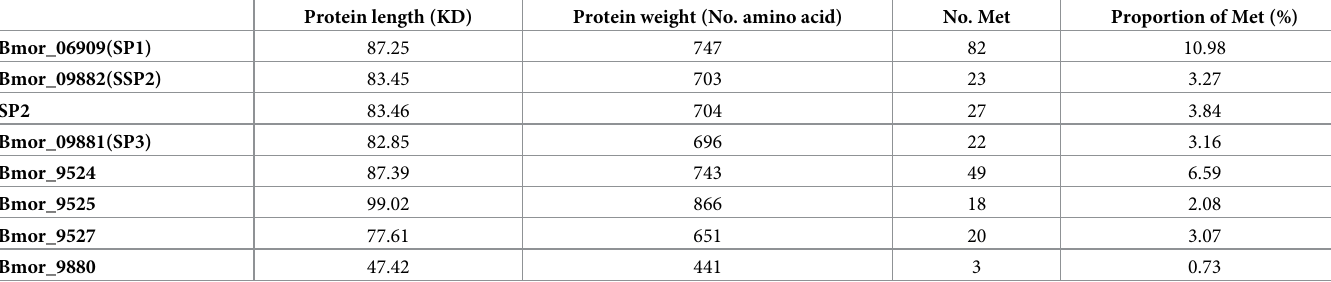
Table 1. Basic information and methionine composition of silkworm SPs.